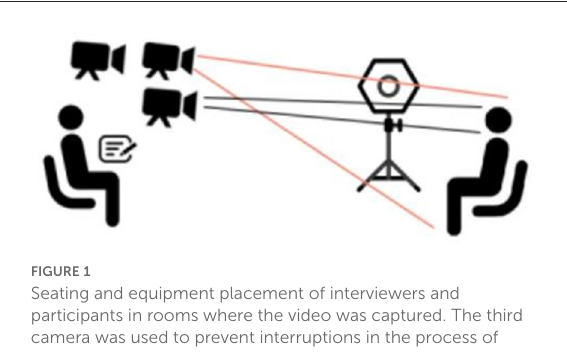
FIGURE1 Seating and equipment placement of interviewers and participants in rooms where the video was captured. The third camera was used to prevent interruptions in the process of saving the video to the cloud in real